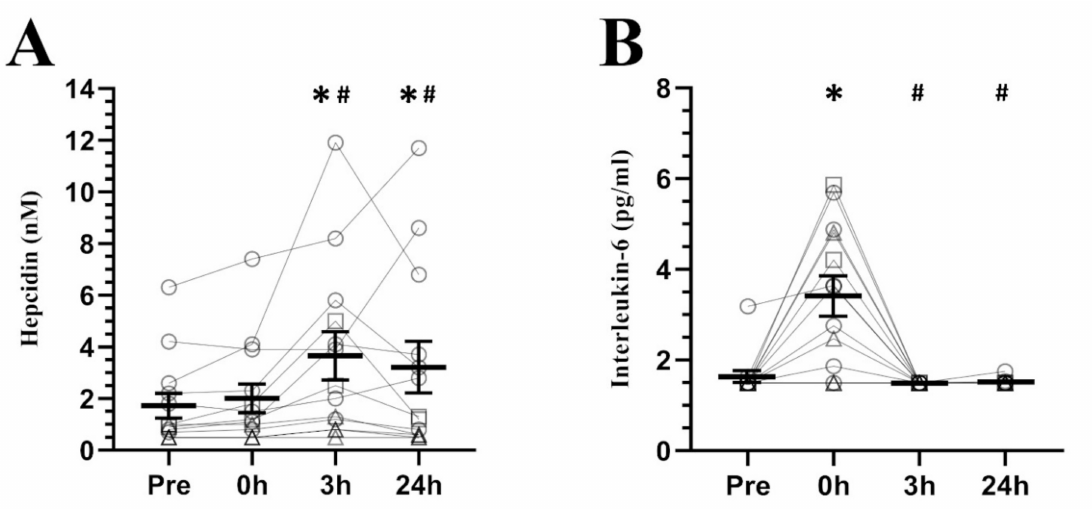
Figure 1. Serum hepcidin ( A ) and interleukin-6 ( B ) concentrations at baseline and its response to a high-intensity interval running session (mean ± SEM). Pre, pre-exercise; 0 h, 0 h post-exercise; 3 h, 3 h post-exercise; 24 h, 24 h post-exercise. * Significantly di ff erent from pre-exercise. # Significantly di ff erent from 0 h post-exercise. Circles = participants with non-depleted ferritin stores ( ≥ 30 ng / mL), Squares = participants with high estrogen concentrations ( > 100 pg / mL) and non-depleted ferritin stores ( ≥ 30 ng / mL), Triangles = participants with depleted ferritin stores ( < 30 ng / mL).